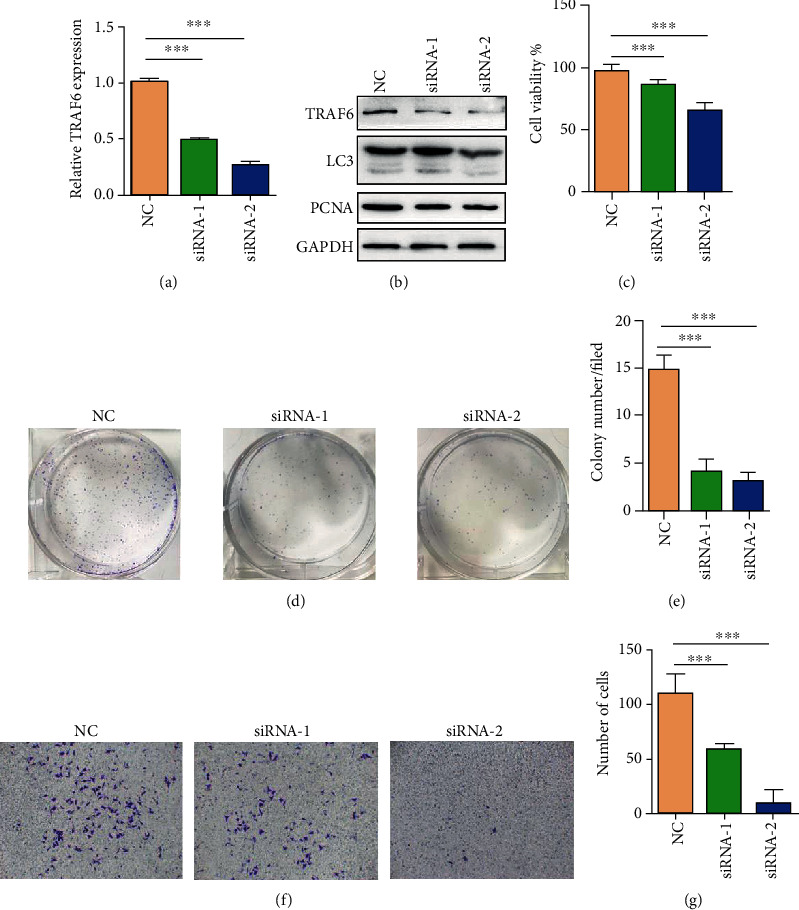
Knockdown of TRAF6 inhibited cell proliferation and migration in HGC-27 gastric cancer cells. (a) Real-time PCR revealed TRAF6 expression in transfected NC and TRAF6 knockdown HGC-27 cells (n = 3, ∗∗∗p < .0001). (b) Western blot was used to confirm the expressions of TRAF6, PCNA, and LC3 in transfected NC and TRAF6 siRNA-transfected HGC-27 cells. (c) CCK8 assay for transfected NC and TRAF6 siRNA-transfected HGC-27 cells; cells were incubated at 37°C for 72 h. (d) Representative images of colony formation for transfected NC and TRAF6 siRNA-transfected HGC-27 cells; cells were cultured for 1 week. (e) Number of clones in (d) (n = 3, ∗∗∗p < .0001). (f) Transwell migration assay for transfected NC and TRAF6 siRNA-transfected HGC-27 cells. (g) Number of migrating cells in (f) (n = 3, ∗∗∗p < .0001).